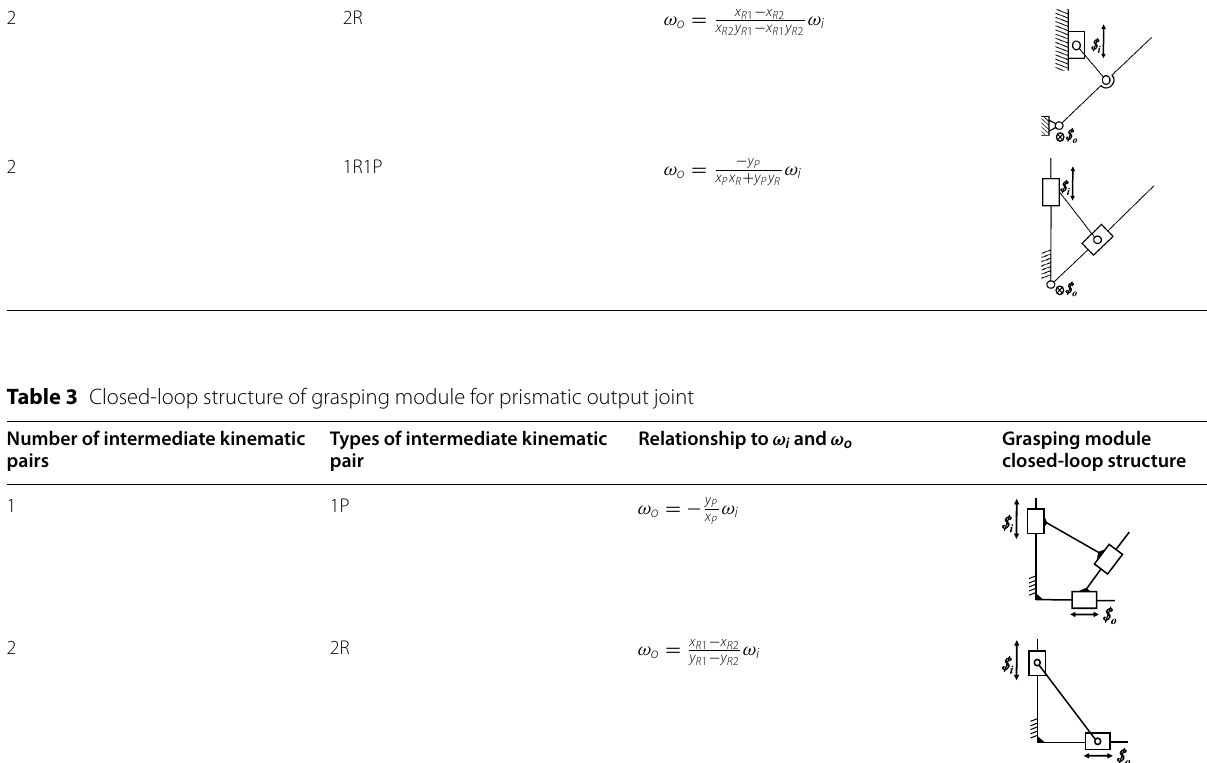
Types of intermediate kinematic pair